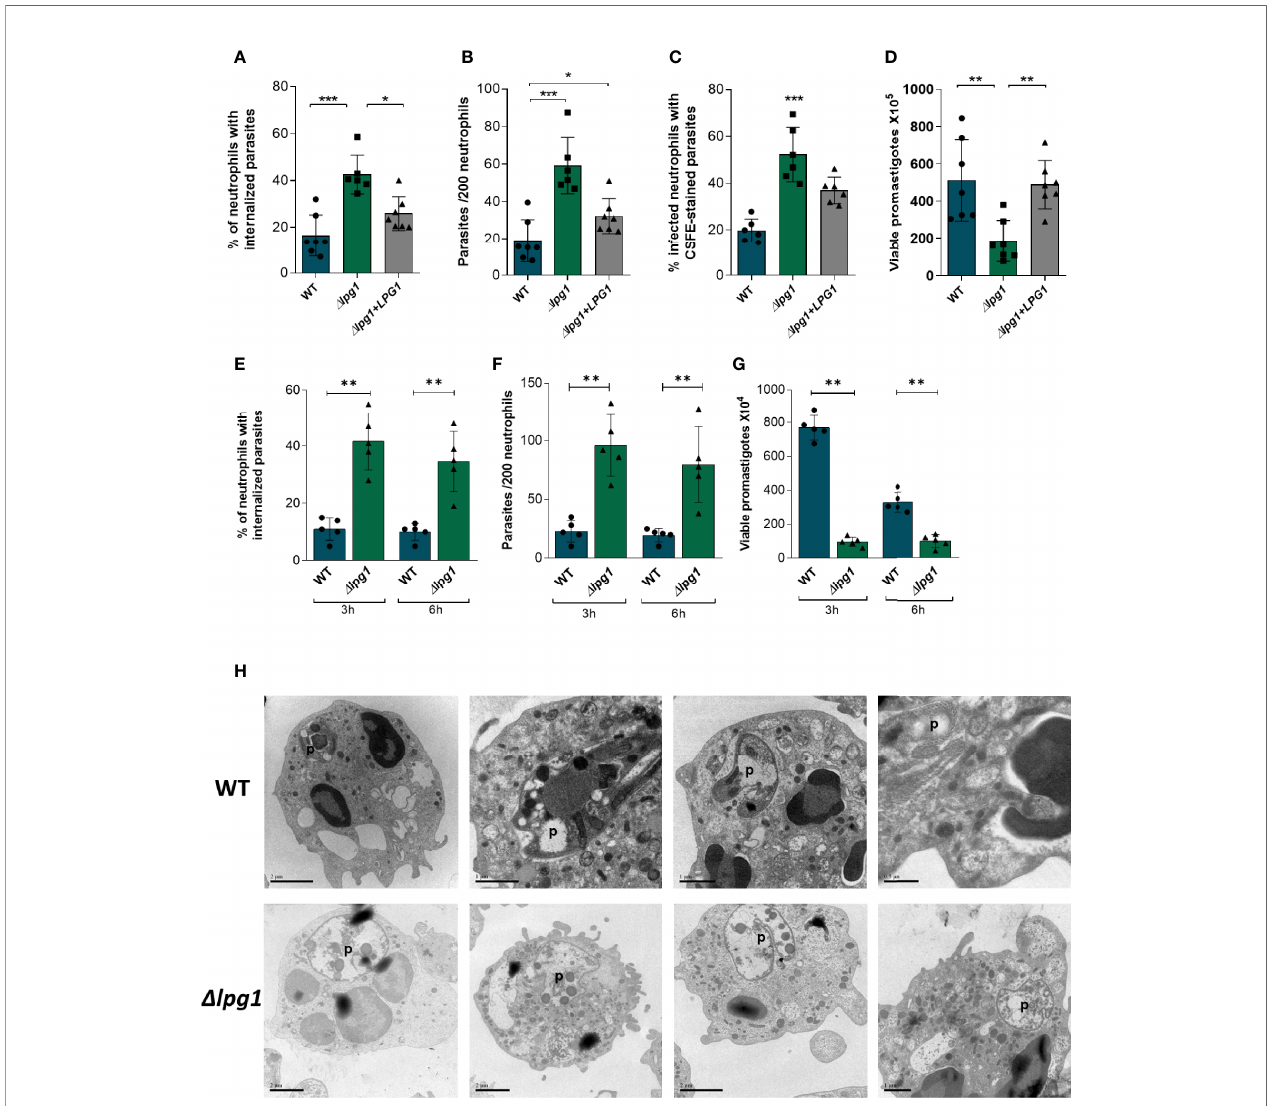
FIGURE 1 | Viability and ultrastructure of Lpg1-null mutants in neutrophils. Human neutrophils were infected with L. infantum WT, Δ lpg1 , or Δ lpg1+LPG1 for 3 h Light microscopy was used to assess the percentage of neutrophils that contained internalized parasites (A) and number of parasites per 200 neutrophils (B) . Flow cytometry was used to examine the percentage of neutrophils containing CSFE-labeled parasites (C) . In similar experiments, human neutrophils were infected for 3 h, when the culture medium was replaced by HOMEM medium. Count of released viable promastigotes in supernatant was performed after 24 h (D) . Each point in the graphs represents a donor; bars represent median values and whiskers infer interquartile ranges. Asterisks indicate statistically signi fi cant differences assessed by the non-parametric Kruskal – Wallis test with Dunn ’ s multiple comparisons ad hoc test (* p < 0.05, ** p < 0.01, *** p < 0.001). Human neutrophils were infected with L. infantum WT or Δ lpg1 (1:10) for 3 and 6 h Light microscopy was used to assess the percentage of neutrophils that contained internalized parasites (E) and the number of parasites per 200 neutrophils (F) . In similar experiments, human neutrophils were infected for 3 and 6 h when the culture medium was replaced by HOMEM medium. The number of released viable promastigotes in the supernatant was obtained after 24 h (G) . Each dot in the graphs represents a donor; bars represent median values, and whiskers infer interquartile ranges. Asterisks indicate statistically signi fi cant differences evaluated through the non-parametric Mann – Whitney U test (** p < 0.01). Human neutrophils were infected for 3 h with L. infantum WT or Δ lpg1 , processed and analyzed by transmission electron microscopy (TEM); representative images are shown (H)